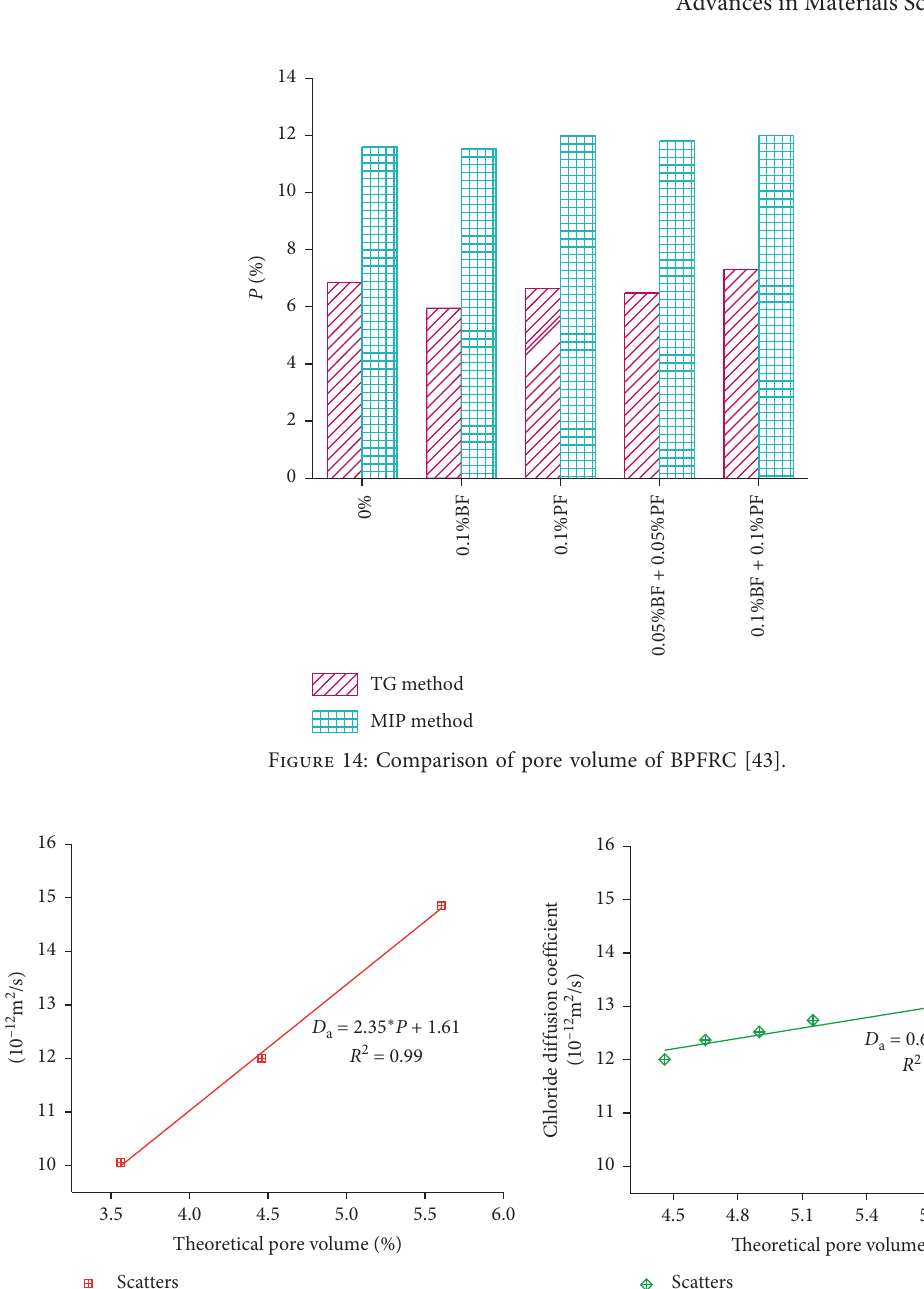
a after 30d of erosion. (a) Different strength grades. (b) Different fiber